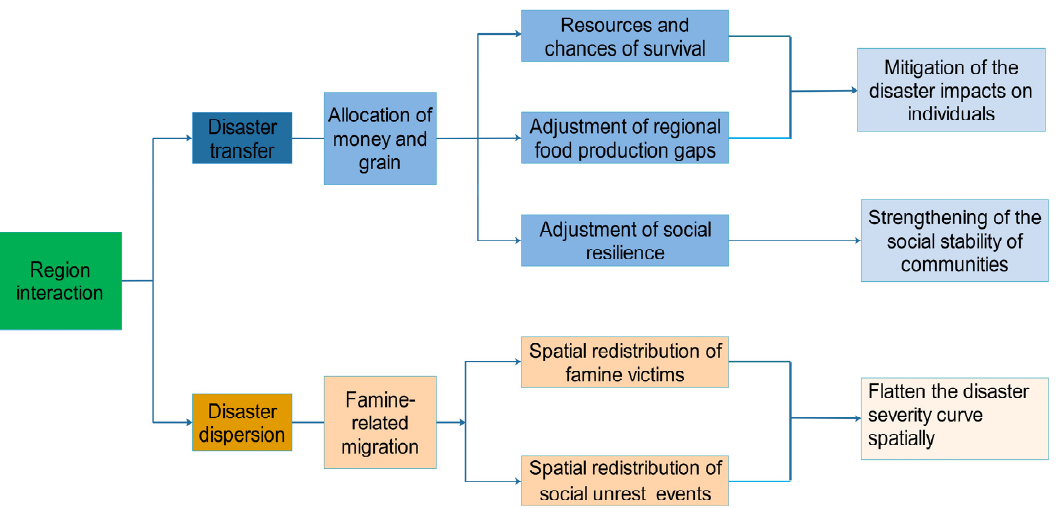
Figure 9. Process of regional interaction responses and transfer-dispersion of the impacts of disasters.